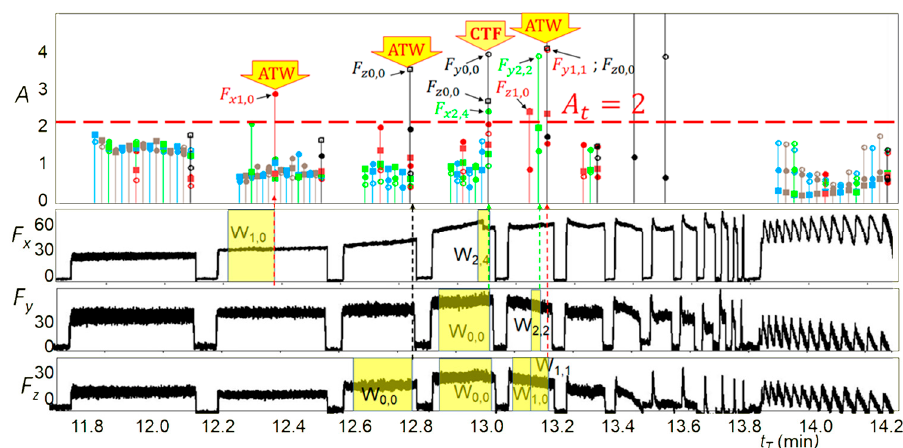
Figure 4. Results of the gradual tool wear estimation algorithm (GTW) [47].